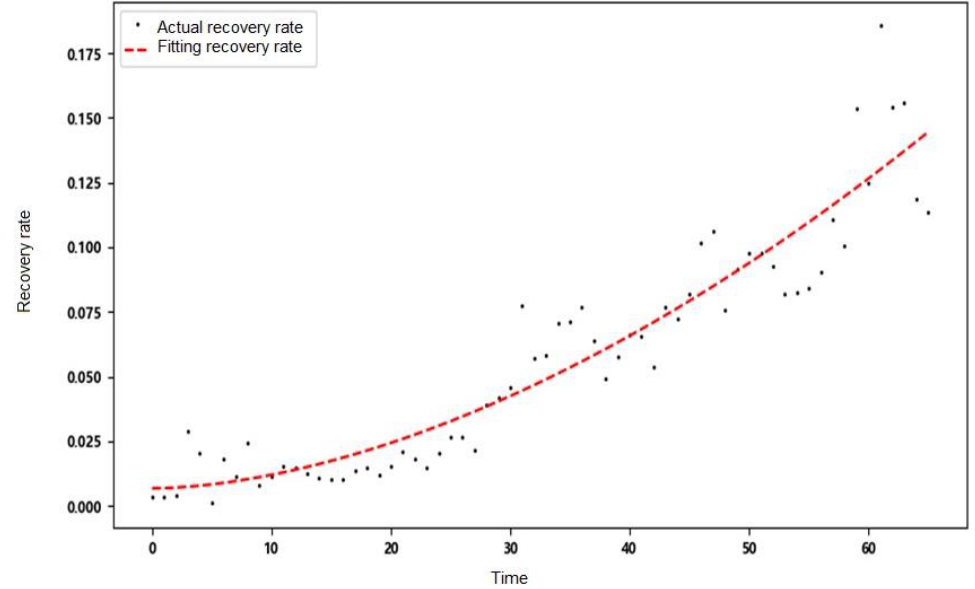
Figure 3. Fitting results of daily recovery rate.